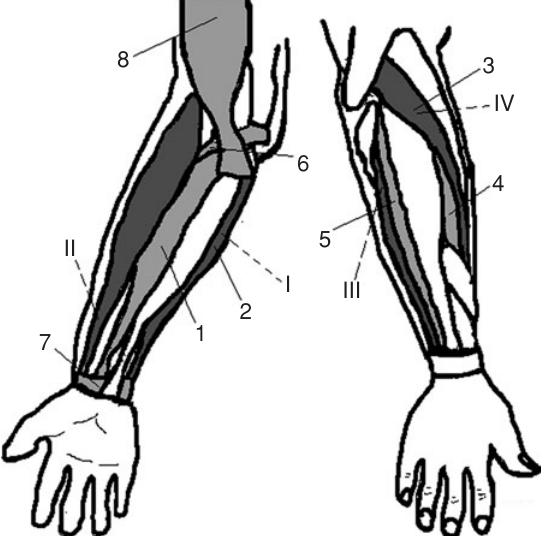
Figure 1 Muscle positions.